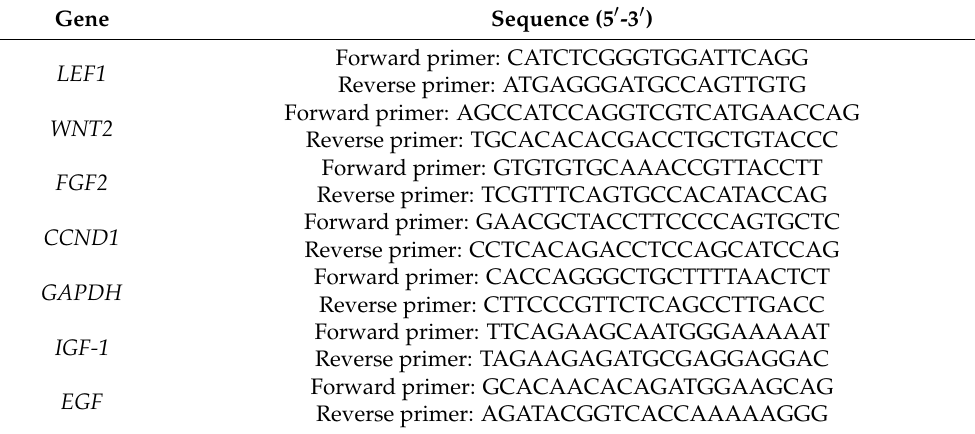
Table 1. Primer sequences used for quantitative real-time polymerase chain reaction (qRT-PCR).